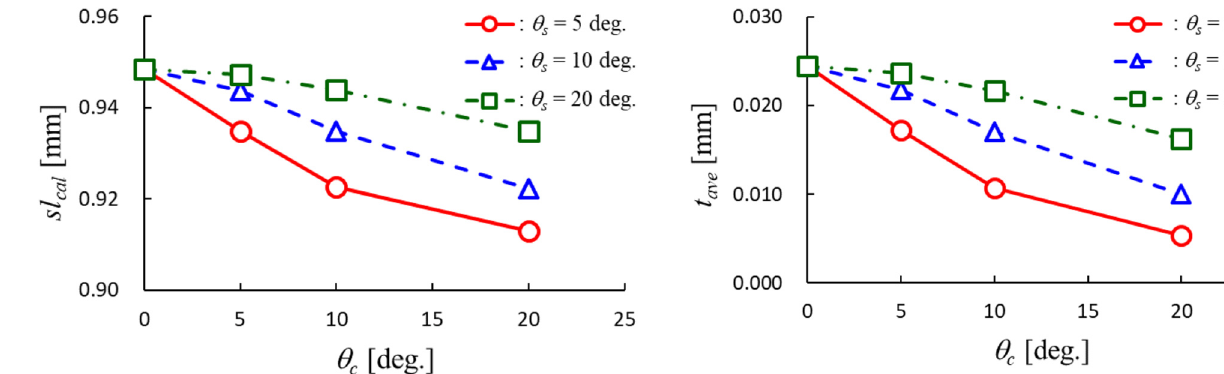
Fig. 13. In fl uence of u s and u c on L cal .